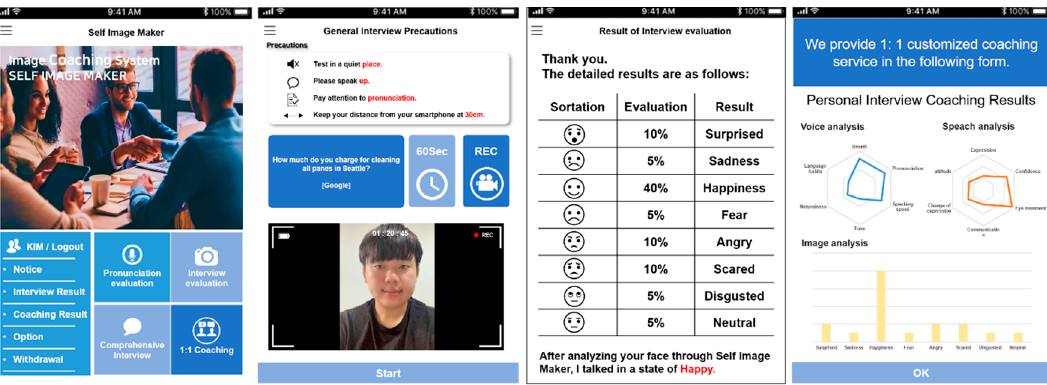
Figure 18. The real-time interview management mobile application. * The figure included in this image is the author, who agreed to provide the